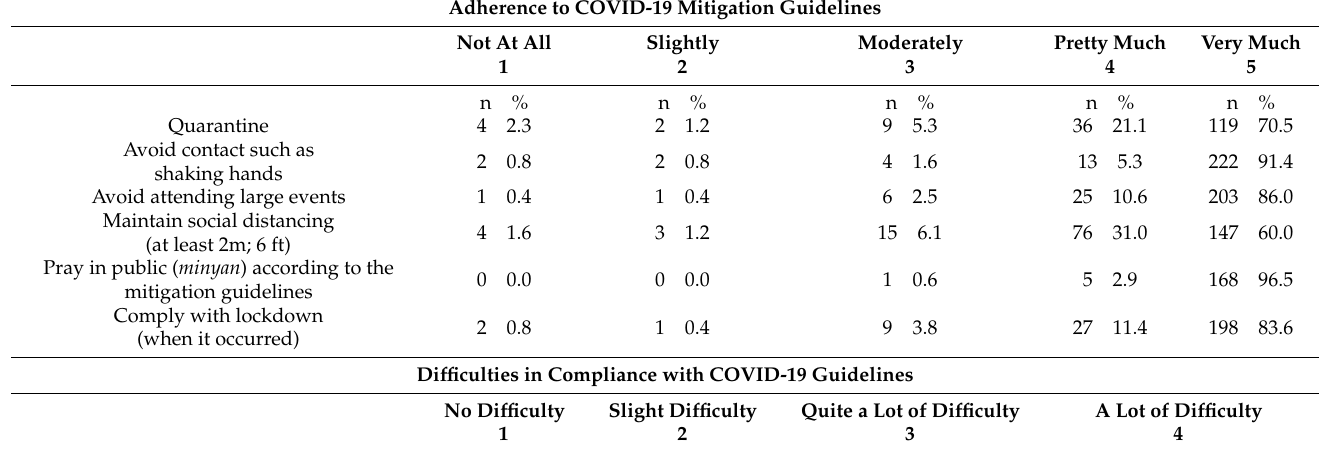
Adherence to COVID-19 Mitigation Guidelines Not At All Slightly Moderately 1 2